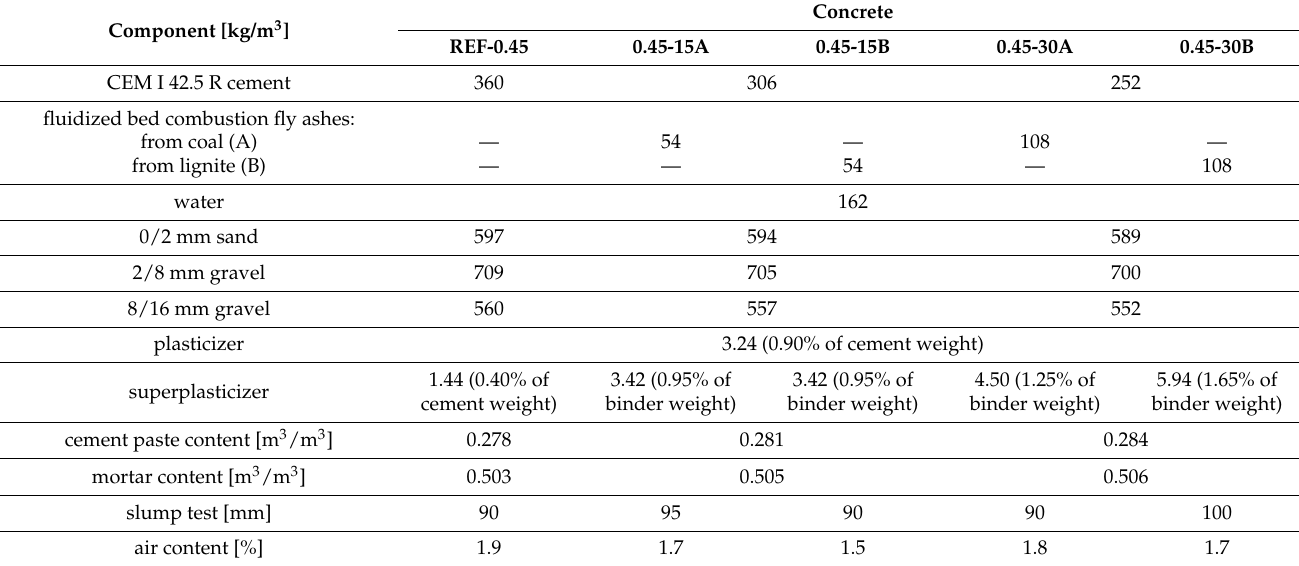
Table 7. Composition of concretes with w / b ratio = 0.45 without and with fluidized bed combustion fly ashes. Component [kg/m 3